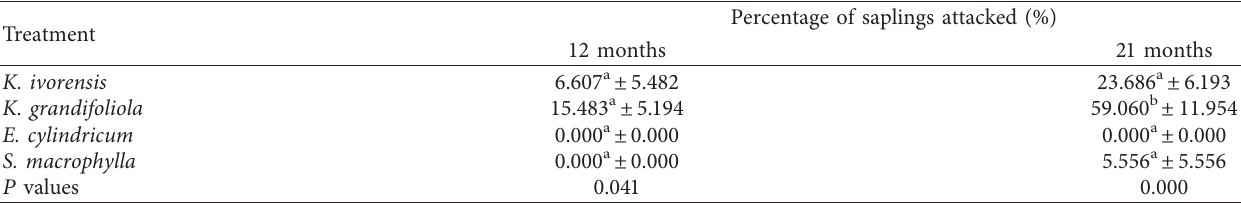
Table 1: Percentage of K. grandifoliola, S. macrophylla, K. ivorensis, and E. cylindricum saplings attacked in the species trial after 12 and 21 months in the moist semideciduous